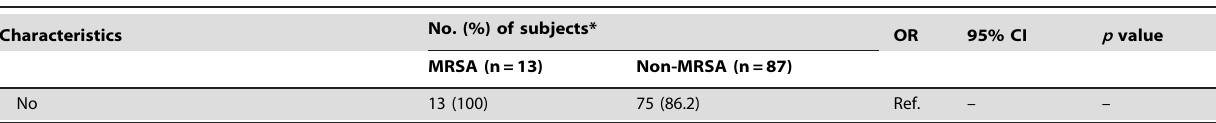
Characteristics